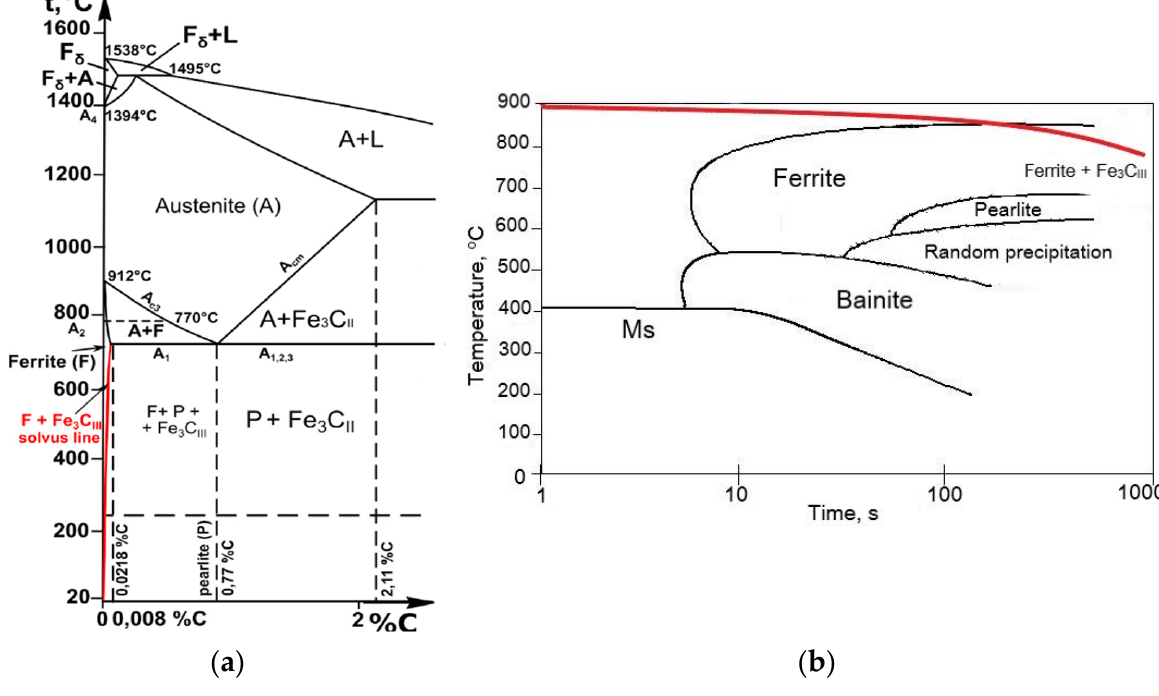
Figure 1. Transformations in equilibrium state and during cooling of low carbon steels, ( a ) Fe ‐ Fe 3 C phase diagram [22], ( b ) CCT diagram presenting slow ‐ cooling after austenitizing [23], (red curves symbolize the precipitation regions of Fe 3 C III phase).